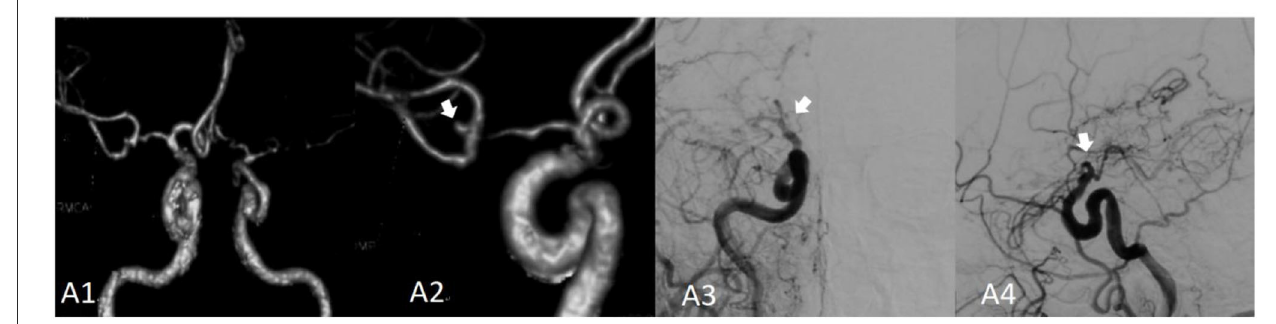
FIGURE1 Moyamoya disease combined with a bifurcation aneurysm of the right middle cerebral artery. (A1) Shows the computed tomography angiography (CTA) image of the bilateral internal carotid artery in 2014; (A2) shows the locally enlarged CTA of the right internal carotid artery; the aneurysm is indicated by the white arrow. (A3) Presents the right internal carotid artery angiography (red arrow) image. (A4) Presents the right internal carotid artery angiography image; the distal end of the internal carotid artery is not occluded, and the parent artery and aneurysm have